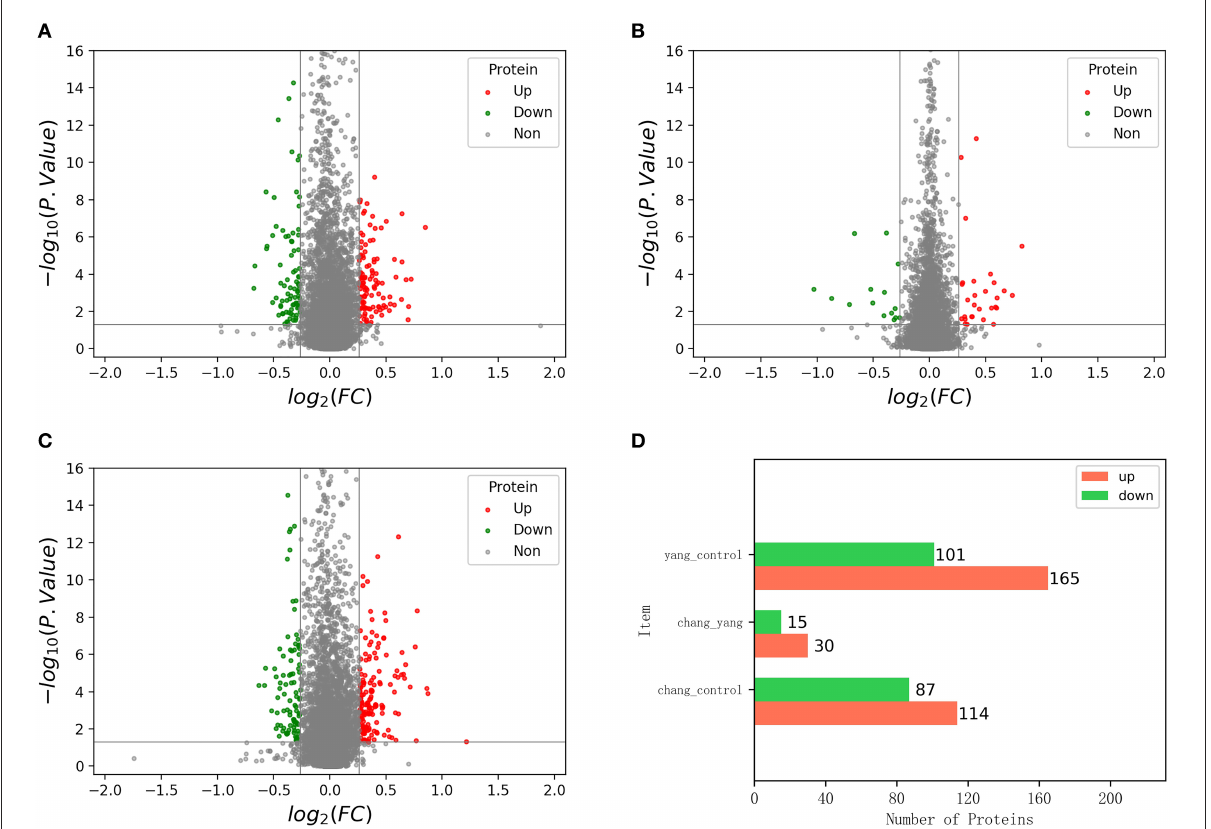
FIGURE6 The volcano map of differentially expressed proteins; (A) is the volcano map of control group vs. fish sausage group; (B) is the volcano map of positive control group vs. fish sausage group; (C) is the volcano map of control group vs. positive control group; (D) is the number of up-and down-regulated differential proteins in each comparison